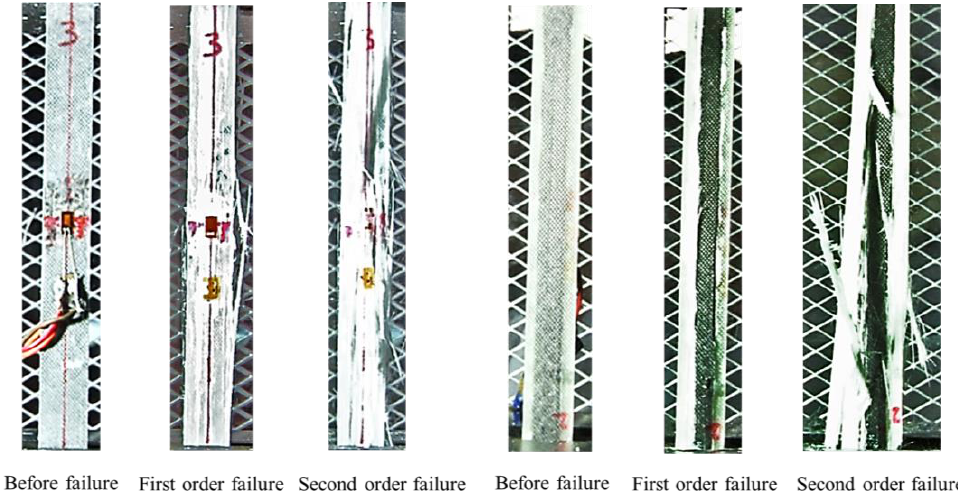
Figure 9. Failure process of hybrid composites: ( a ) Interlayer hybrid structure [G/C/G]; ( b ) intralayer hybrid structure.